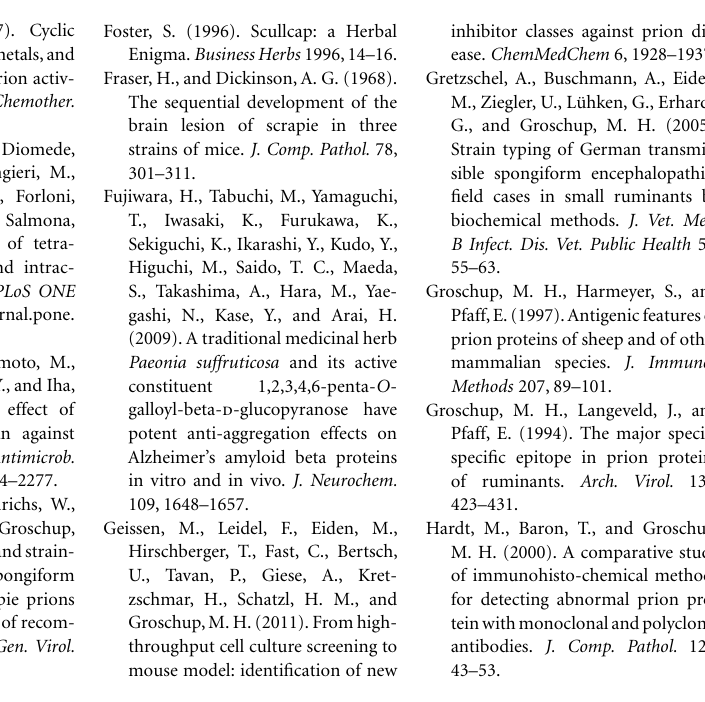
neuroprotectiveeffect(Lietal.,2010).Baicaleinisabletominimize